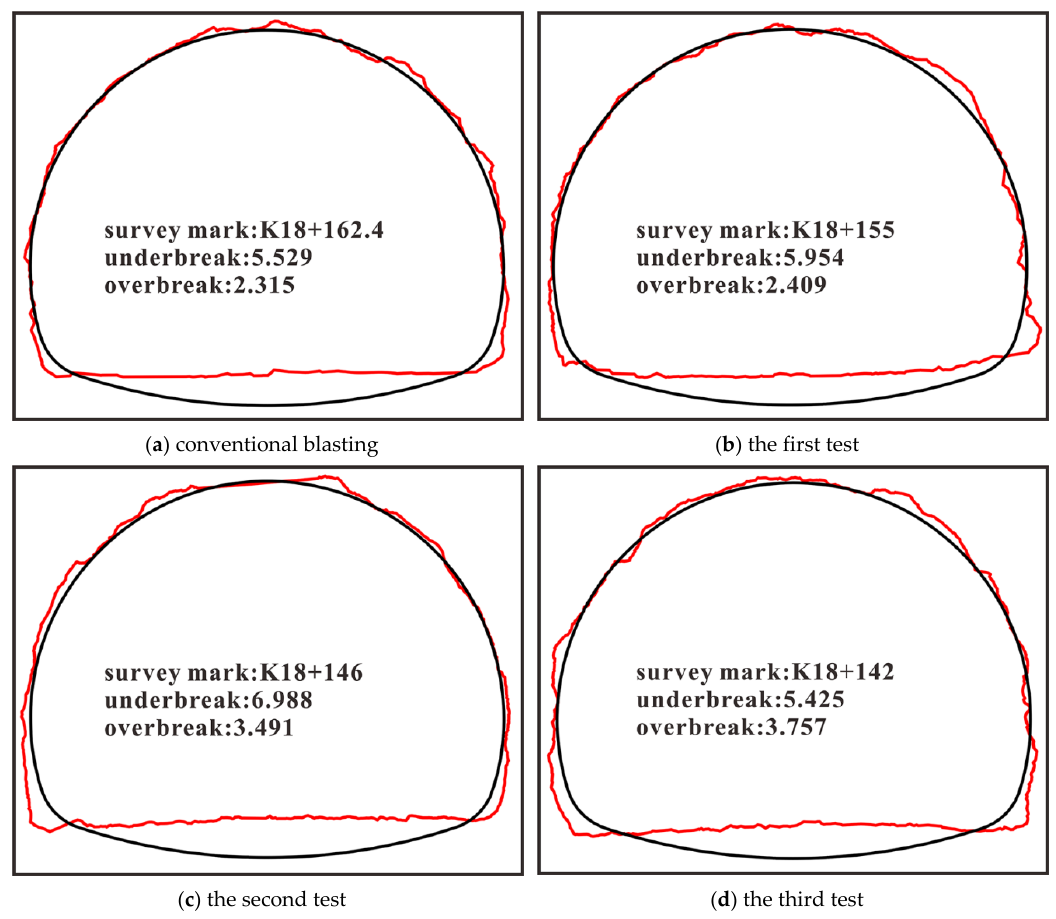
Figure 10. Scanning photos of tunnel profiles. ( a ) the actual and theoretical excavation profile of conventional blasting, ( b ) the actual and theoretical excavation profile of the first test, ( c ) the actual and theoretical excavation profile of the second test, ( d ) the actual and theoretical excavation profile of the third test.